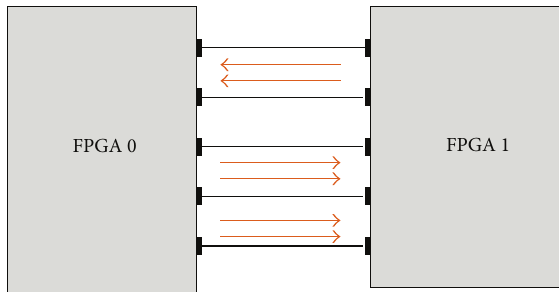
Figure8:Unidirectionalwiresselectionproportionaltothenumber of signals.